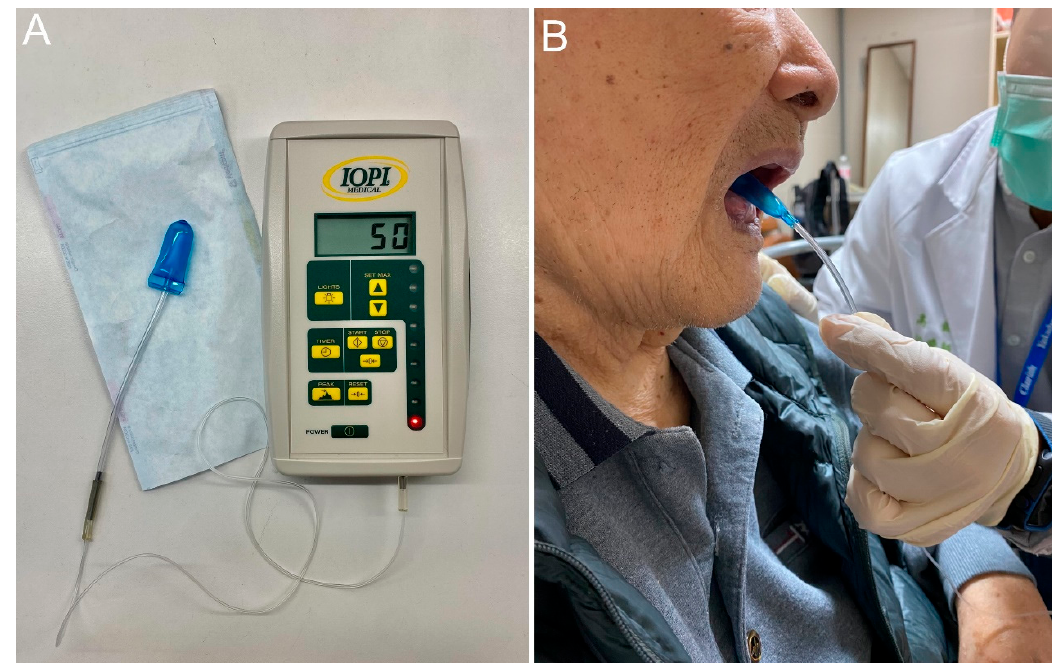
Figure 4. The Iowa oral performance instrument ( A ) and how it is used for obtaining maximal tongue pressure ( B ).